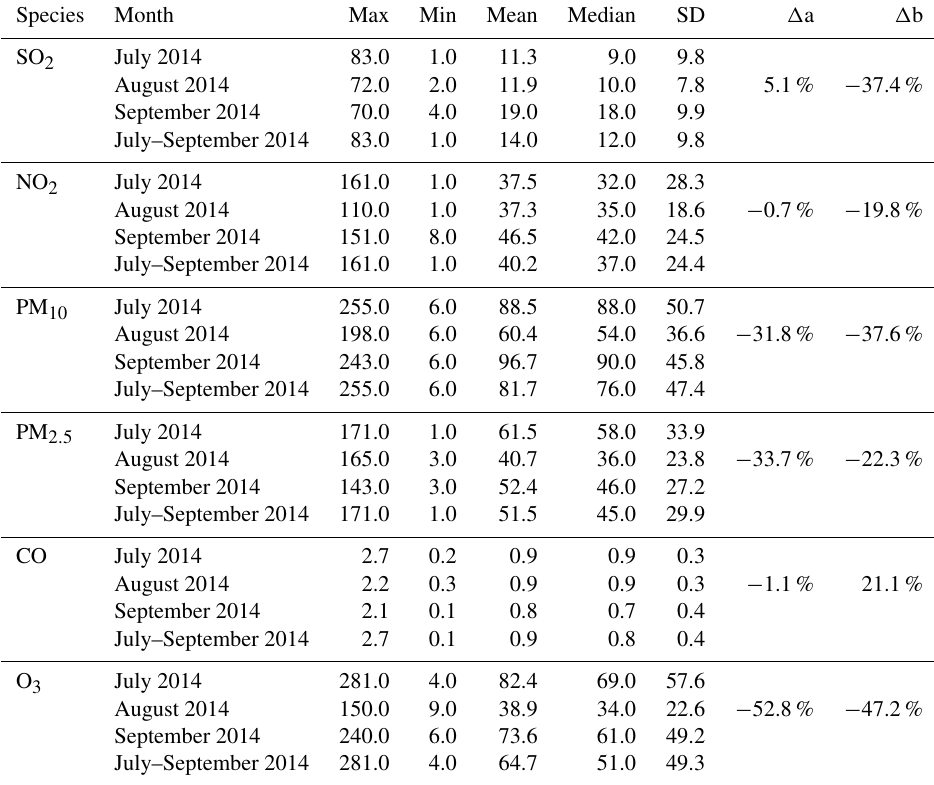
Table 4. Statistical analysis of hourly data in July–September 2014 at CCM station (the unit is µgm − 3 except for CO (mgm − 3 ) ). The change percentage of species ( (cid:49) a) in August 2014 is based on July 2014. The change percentage of species ( (cid:49) b) in August 2014 is based